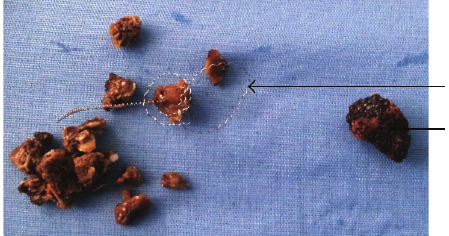
Figure 4: The fragmented renal pelvic stone (straight line) with the migrated embolization coil (arrow